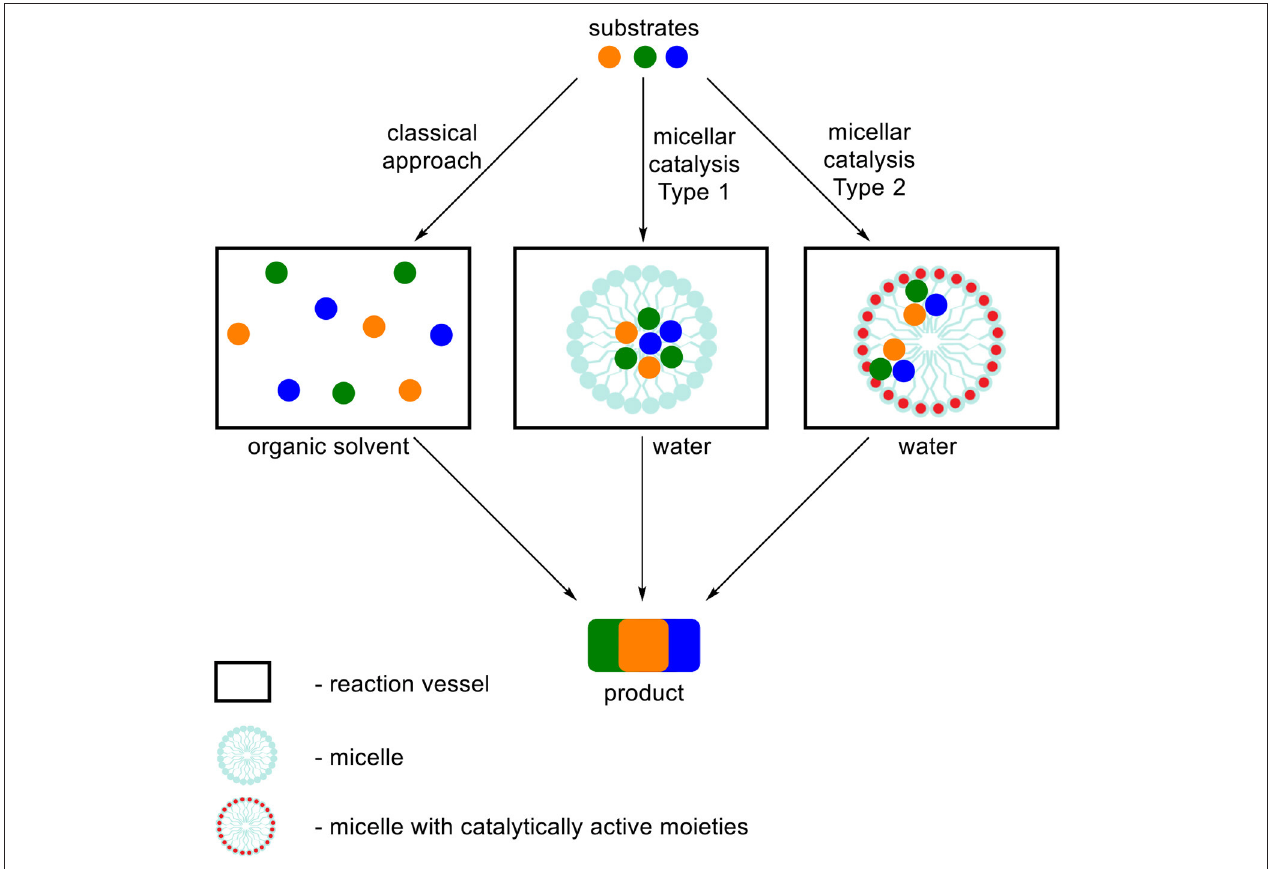
FIGURE 1 | Schematic representation of two types of micellar catalysis summarized in this review in respect to classical approach for